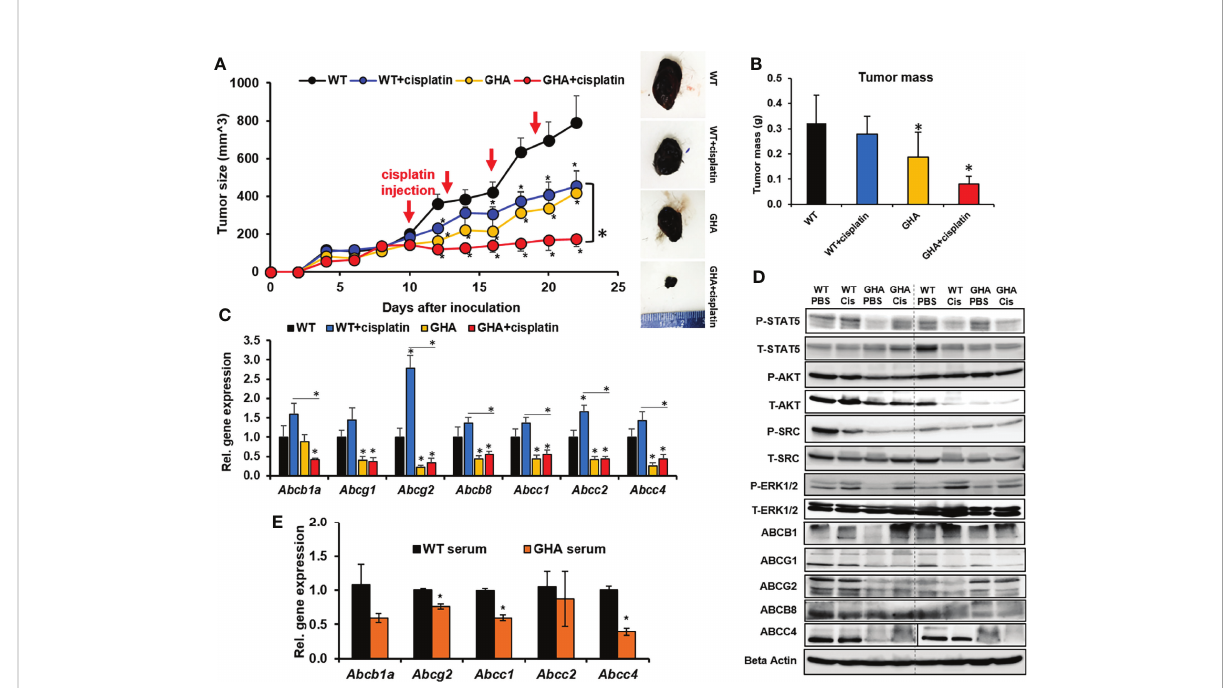
FIGURE 2 Effect of GHRA on response of syngeneic mouse melanoma tumors to cisplatin treatment in vivo . (A) Mouse Fluc-B16-F10 cells grafted intradermally on the right fl ank of syngeneic C57BL6/J wild-type (WT) and GHA mice (transgenic for bGH G119K GHR antagonist) (n=8). The changes in tumor volume (Fluc-B16-F10 in WT and GHA mice) from digital caliper measurement and representative tumors post-dissection (A) and tumor mass (B) corroborate suppressed tumor growth in GHA mice and improved tumoral response to cisplatin in the GHA mice. The qPCR analysis of ABC transporter RNA expression involved in multi-drug ef fl ux from the tumors in WT and GHA mice (C) and western-blot assessment of GH downstream signaling and ABC transporter protein levels (D) are shown. (E) The changes in ABC transporter RNA level in B16-F10 cells in culture when treated with serum collected from WT and GHA mice (*p < 0.05, mouse studies – repeated measure using SPSS; other assays - Students t test, n =